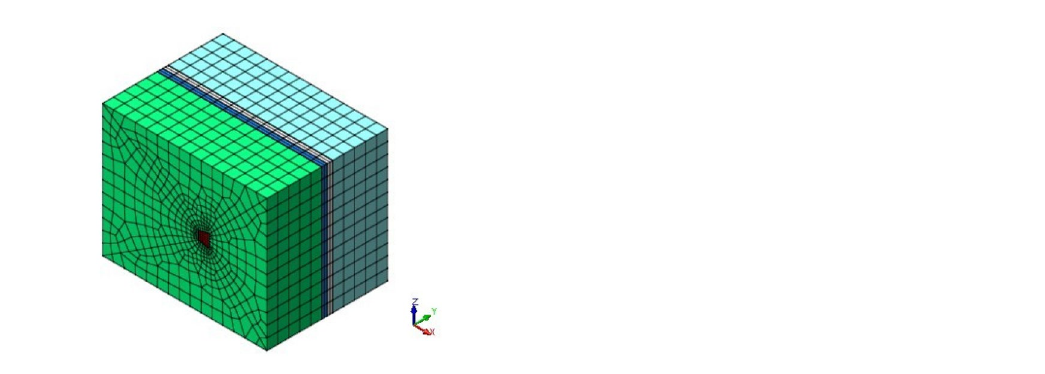
Figure 18. Influence of Anchor Pier Width D e ( 500 on Deformation of Anchorage System.